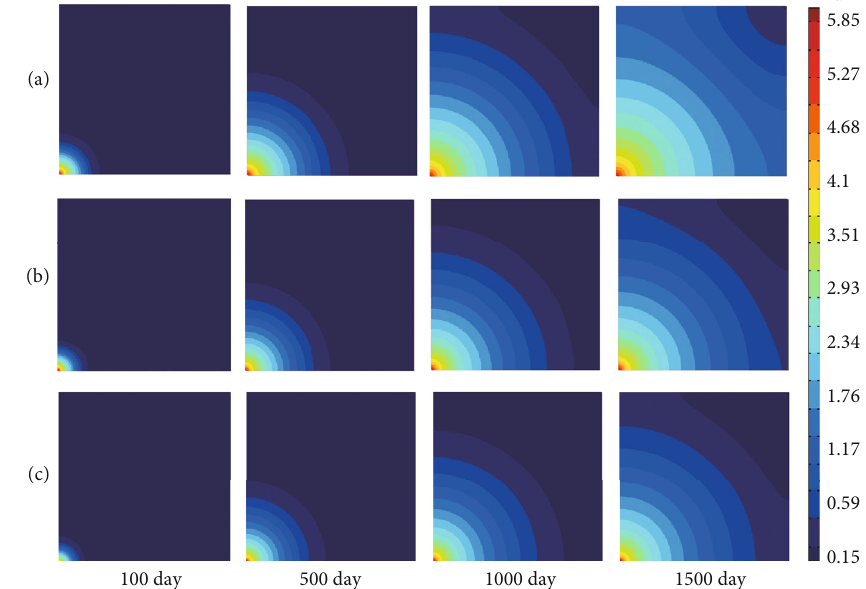
Figure 15: CO migration within di ff erent sti ff ness of coal reservoir. (a) Lower sti ff ness. (b) Medium sti ff ness. (c) Higher sti ff ness. 2